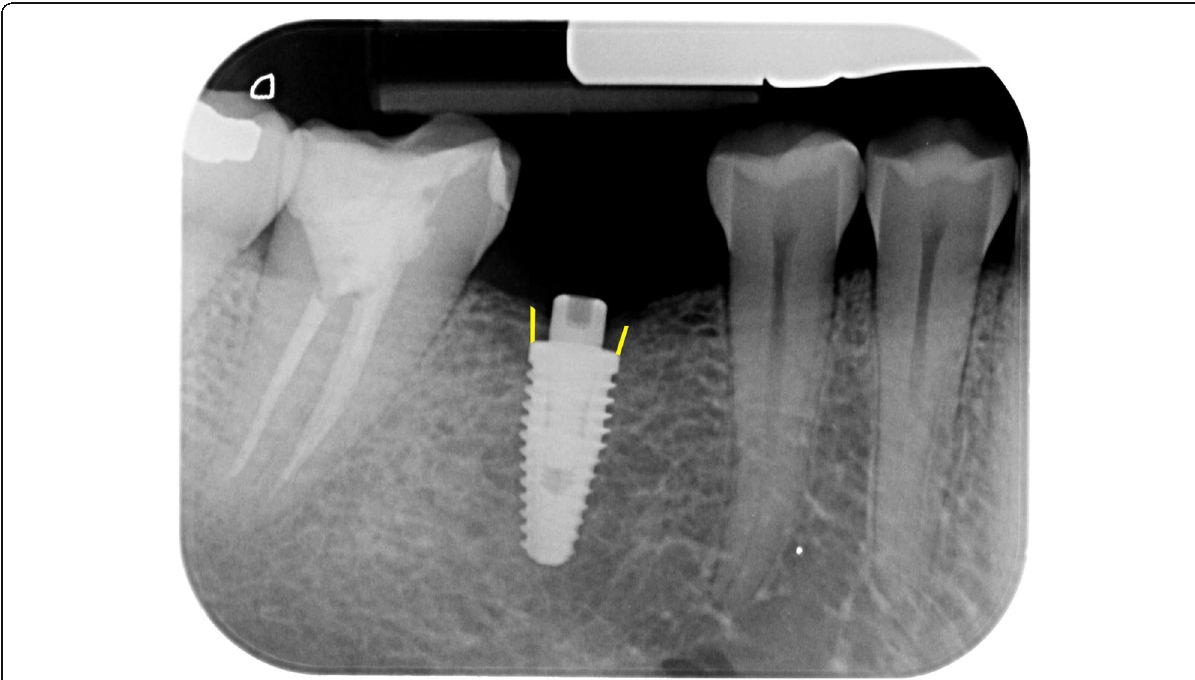
Fig. 1 Representative image of the radiographical assessments. The distance between the implant platform and alveolar bone crest was measured both in mesial and distal regions, in millimeters, and averaged by each